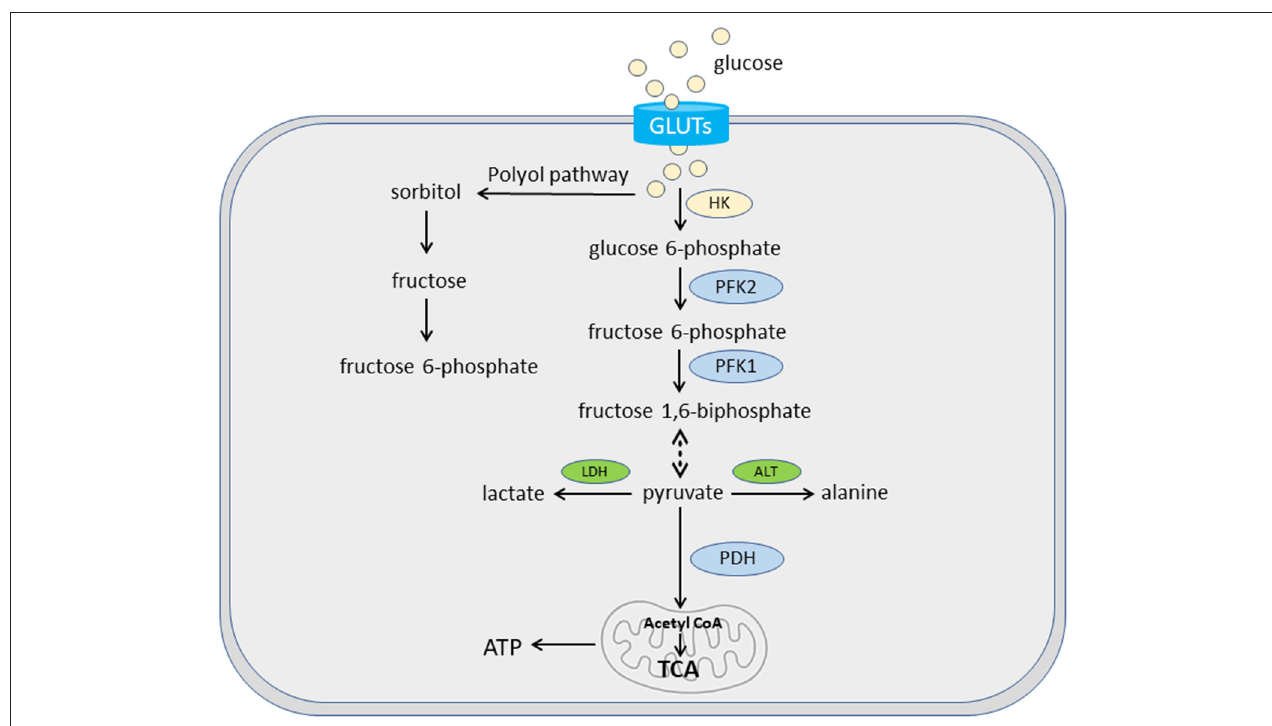
FIGURE 3 | Glucose uptake and oxidation. Glycolysis plays an important role in cardiac bioenergetics. In cardiomyocytes, glucose is transported via glucose transporters (GLUTs). Some glucose is converted to fructose and then fructose 6-phosphate for glycolysis via polyol pathway. The majority of glucose goes through a series of enzymatic reactions of glycolysis to be converted to pyruvate. These enzymes include hexokinase (HK) for glucose 6-phosphate, phosphofructokinase 2 (PFK2) for fructose 6-phosphate, and PFK1 for fructose 1,6-biphosphate. Pyruvate can be reduced to lactate by lactate dehydrogenase (LDH) in cytosol or oxidized to acetyl-CoA by pyruvate dehydrogenase (PDH) in the mitochondria. A small amount of pyruvate can be converted into alanine by alanine transaminase